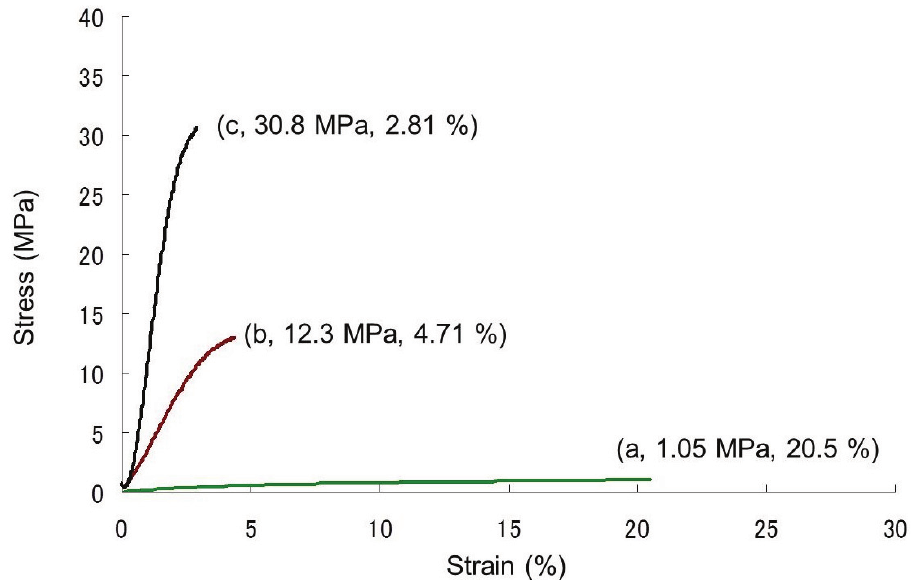
Figure 5. Plausible mechanism for formation of cellulose ion gel.